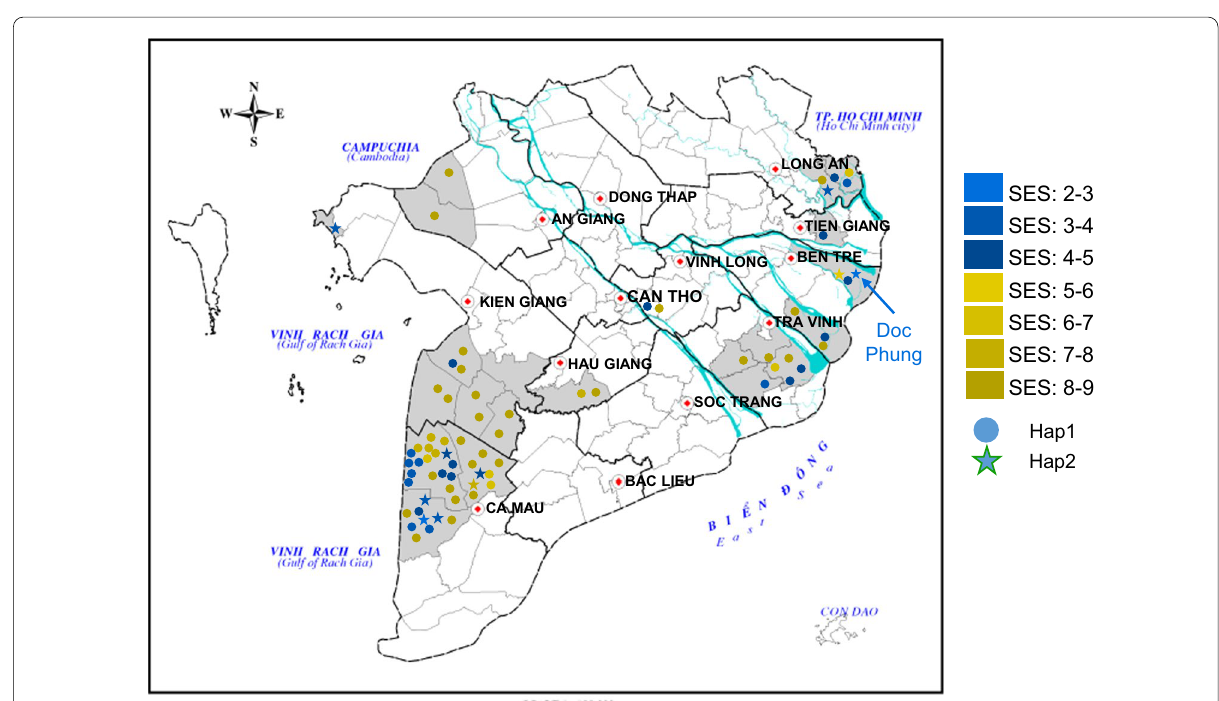
Fig. 7 Geographical distribution of the 71 MDI landrace accessions in the Mekong Delta as a function of their S01_18015212 haplotype. The map shows the Mekong Delta region in Vietnam. Different colors indicate varying SES scores from Fig. 1. The circles and stars indicate Hap 1 (61 accessions) and Hap 2 (10 accessions),